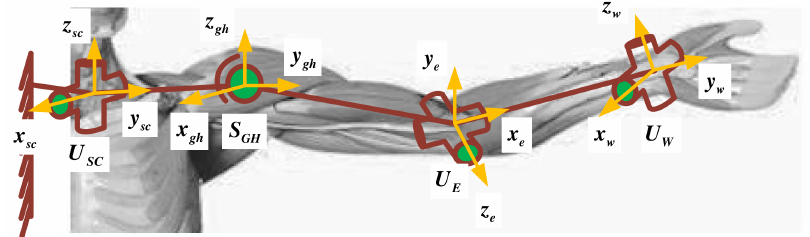
Figure 6. Simplified, equivalent mechanism model of the upper